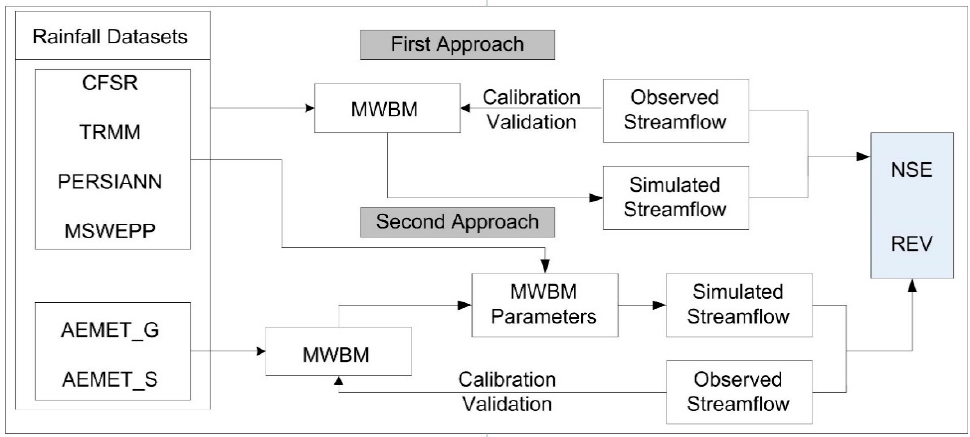
Figure 2. Flowchart for comparative study.